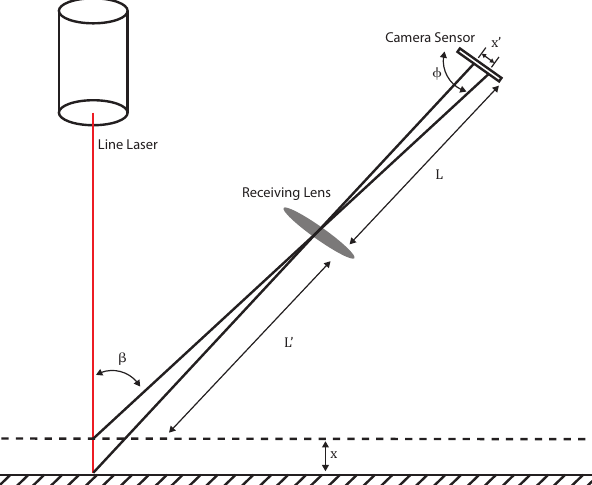
Figure 6. The principle of laser triangulation, where the position of a reflected laser line on a camera sensor is a function of the profile height. Based on an image from Sun B. and Li B. [22]. L and L (cid:48) are the lens to object and to sensor distance, φ is the angle between the lens and the camera sensor which is 90° for our setup, β is the angle between the camera and the laser line. x and x (cid:48) are the physical change in object height and its corresponding change in the laser spot on the sensor. The trigonometric relationship between x and x (cid:48) is determined by